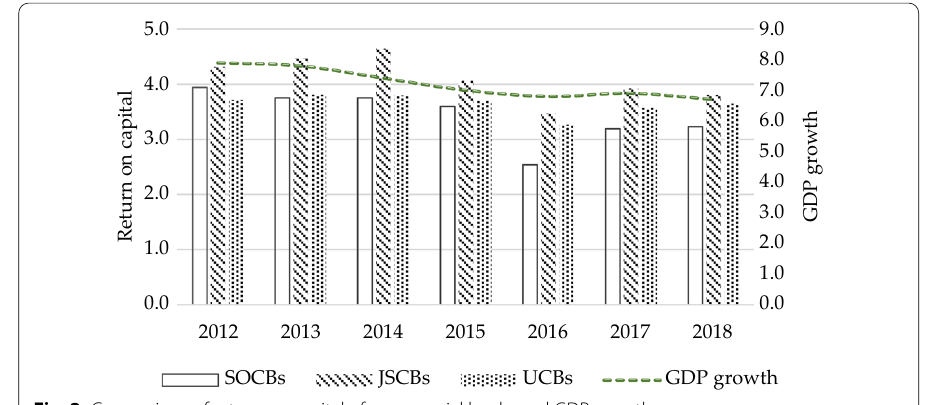
Fig. 2 Comparison of return on capital of commercial banks and GDP